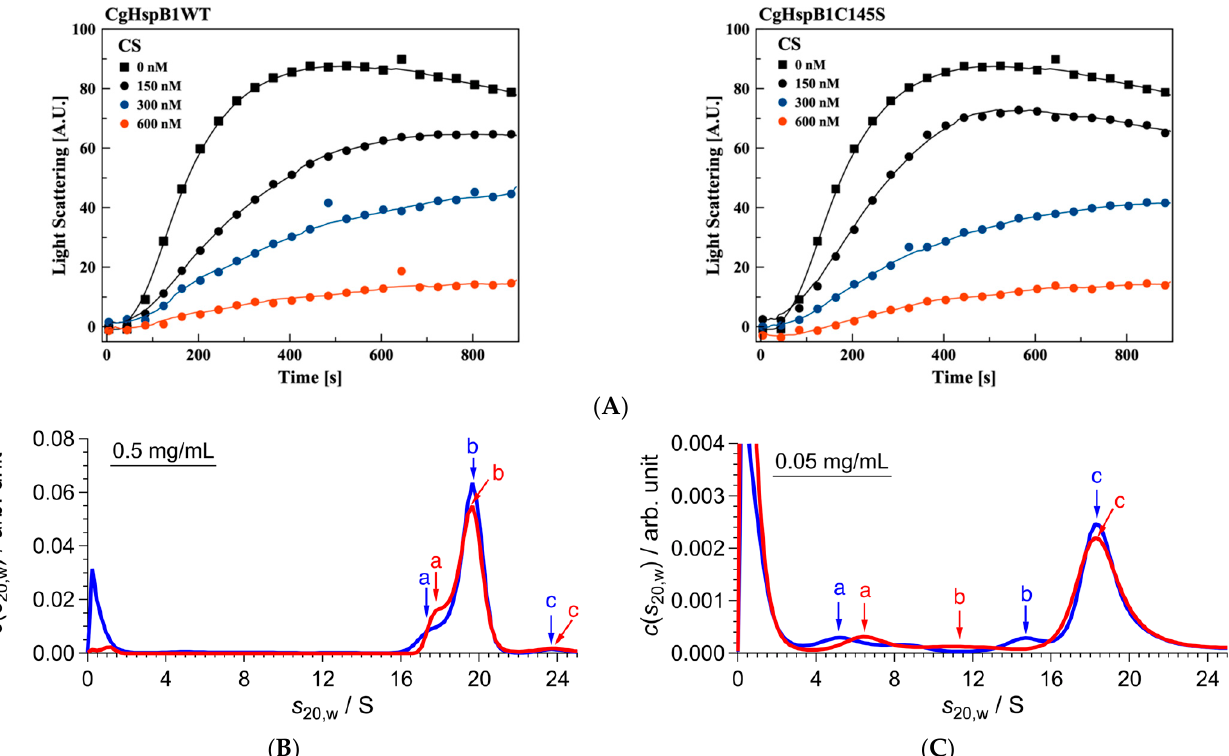
Figure 5. Structure and function of CgHspB1 C145S. ( A ) Comparison of the effects of CgHspB1C145S and CgHspB1WT on the thermal aggregation of citrate synthase. The thermal aggregation of CS from the porcine heart was monitored by measuring light scattering at 500 nm with a spectrofluorometer at 50 °C. CS (50 nM, monomer) was incubated in assay buffer with or without CgHspB1WT and CgHspB1 C145S (150, 300, and 600 nM as monomers). ( B , C ) SV-AUC results of CgHspB1 C145S with and without DTT at 40 °C. Blue and red lines represent c ( s 20,w ) with and without DTT, respectively. ( B , C ) show the results at 0.5 mg/mL and 0.05 mg/mL, respectively. Colored arrows and letters (a, b, c) corresponding to the data with the same colors show the peak positions whose parameters are listed in Table 4. Parameters of peak positions of c ( s 20,w ) in Figure 5B.